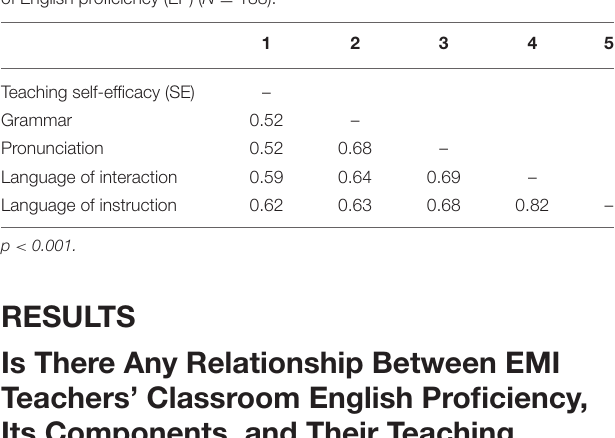
TABLE 2 | Pearson Correlations of teaching self-efficacy (SE) and the constructs of English proficiency (EP) ( N = 188).